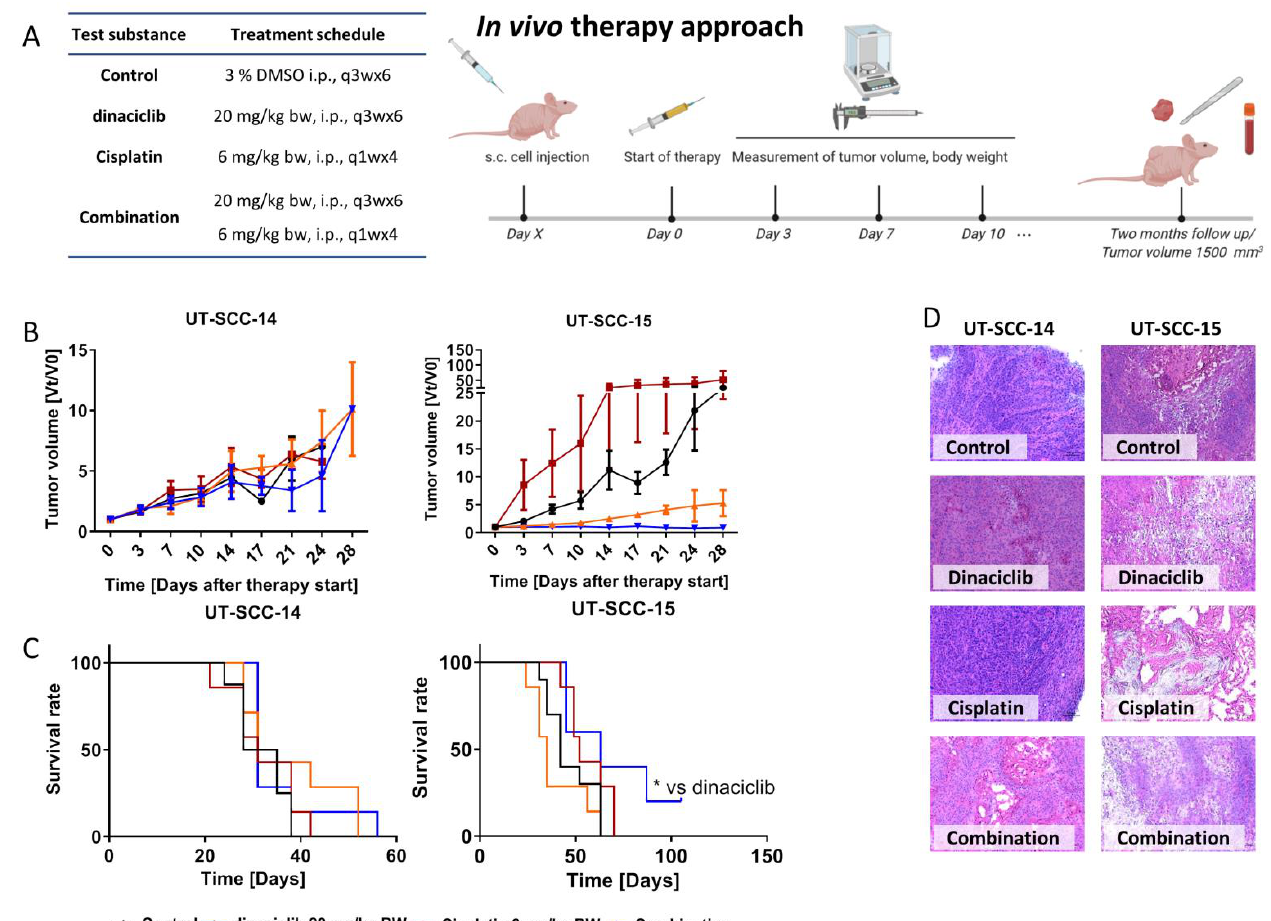
Figure 7. In vivo therapy approach. ( A ) Schematic overview over the treatment protocol with given doses of the test substances. ( B ) Tumor growth curve. Tumor volume was calculated as tumor volume at day × (Vt) divided through the tumor volume at the therapy start (V0). ( C ) Kaplan-Meier survival curve and Log-rank (Mantel-Cox) test. UT-SCC-14: control ( n = 8 mice); Cisplatin/dinaciclib/combination ( n = 7 mice/group); UT-SCC-15: control ( n = 10 mice); Cisplatin/dinaciclib ( n = 7 mice/group); combination ( n = 5 mice); * p < 0.05 vs. dinaciclib. ( D ) Representative images of the HE stained tumors of each treatment group. Magnification 20×, Scale bar.